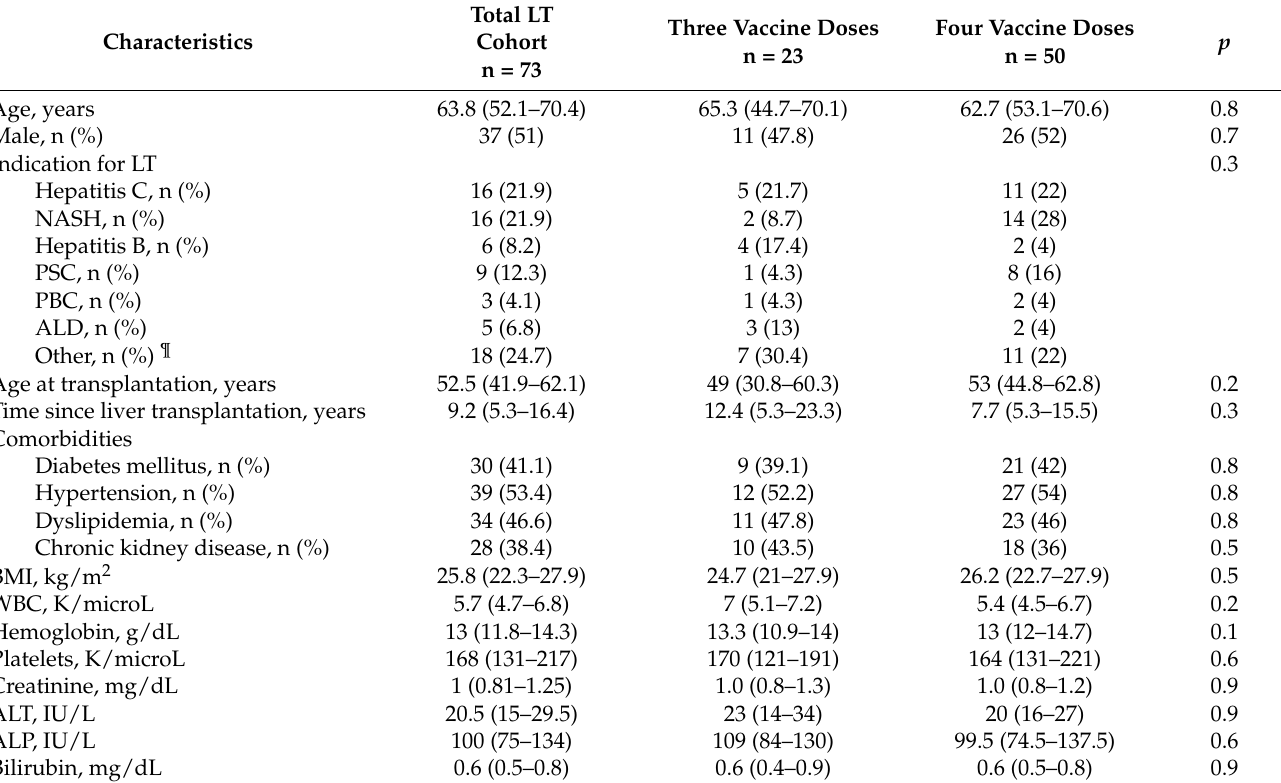
Table 1. Baseline demographics, clinical, and laboratory characteristics of patients who received three vs. four doses of the BNT162b2 mRNA